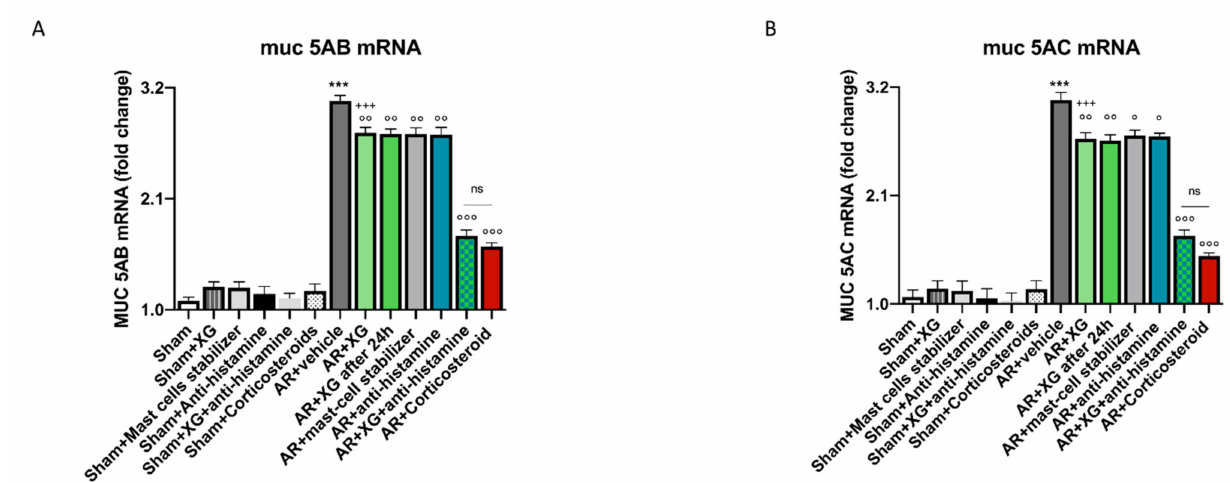
Figure 12. Effect of XG treatment on MUC5AB and MUC5AC expressions. MUC5AB and MUC5AC expression were increased in AR-mice compared to the sham group ( A , B ). XG single treatments considerably reduced the mRNA expression for both mucins with similar efficacy to the to the antihistamine and mast-cell stabilizer treatments ( A , B ). Moreover, XG and antihistamine co-treatment has been shown to decrease MUC5AB and MUC5AC expression, analogously to treatment with corticosteroid ( A , B ). Data are representative of at least three independent experiments. Values are means ± SEM. One-Way ANOVA test. *** p < 0.001 vs. Sham; ◦ p < 0.05 vs. AR + vehicle; ◦◦ p < 0.01 vs. AR + vehicle; ◦◦◦ p < 0.001 vs. AR+vehicle; +++ p 0.001 vs. AR+Corticosteroid. ns: not